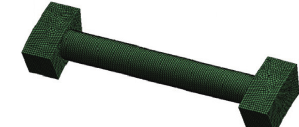
Figure 5: Mesh of the